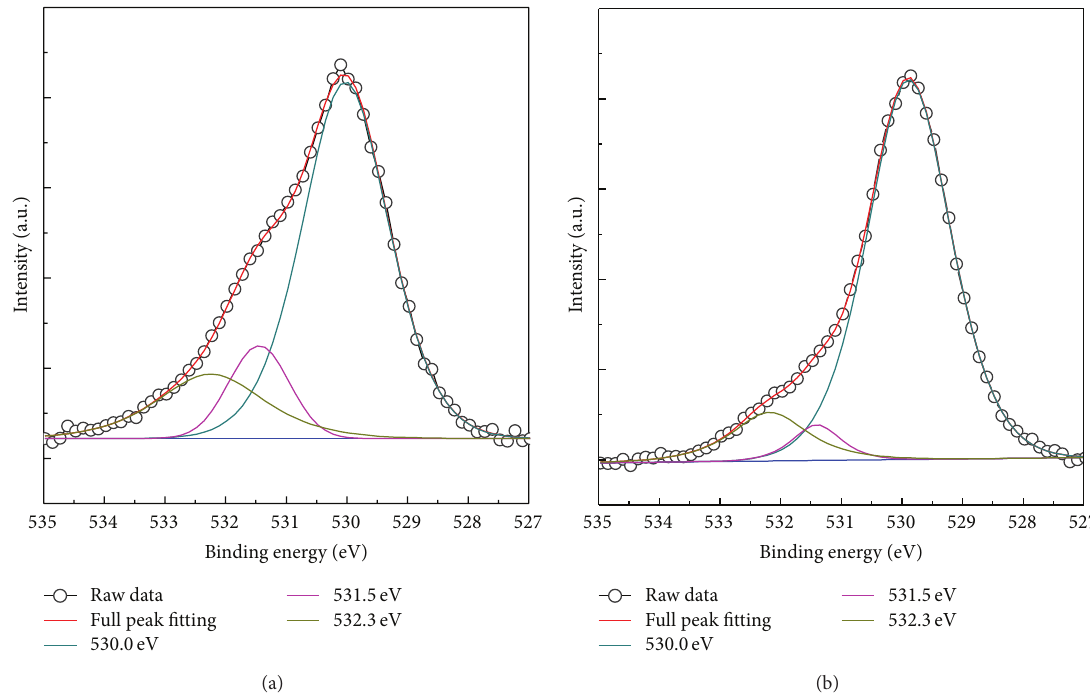
Figure 3: XPS data of O 1 s and its Gaussian-resolved component for the sample deposited under (a) 𝑃